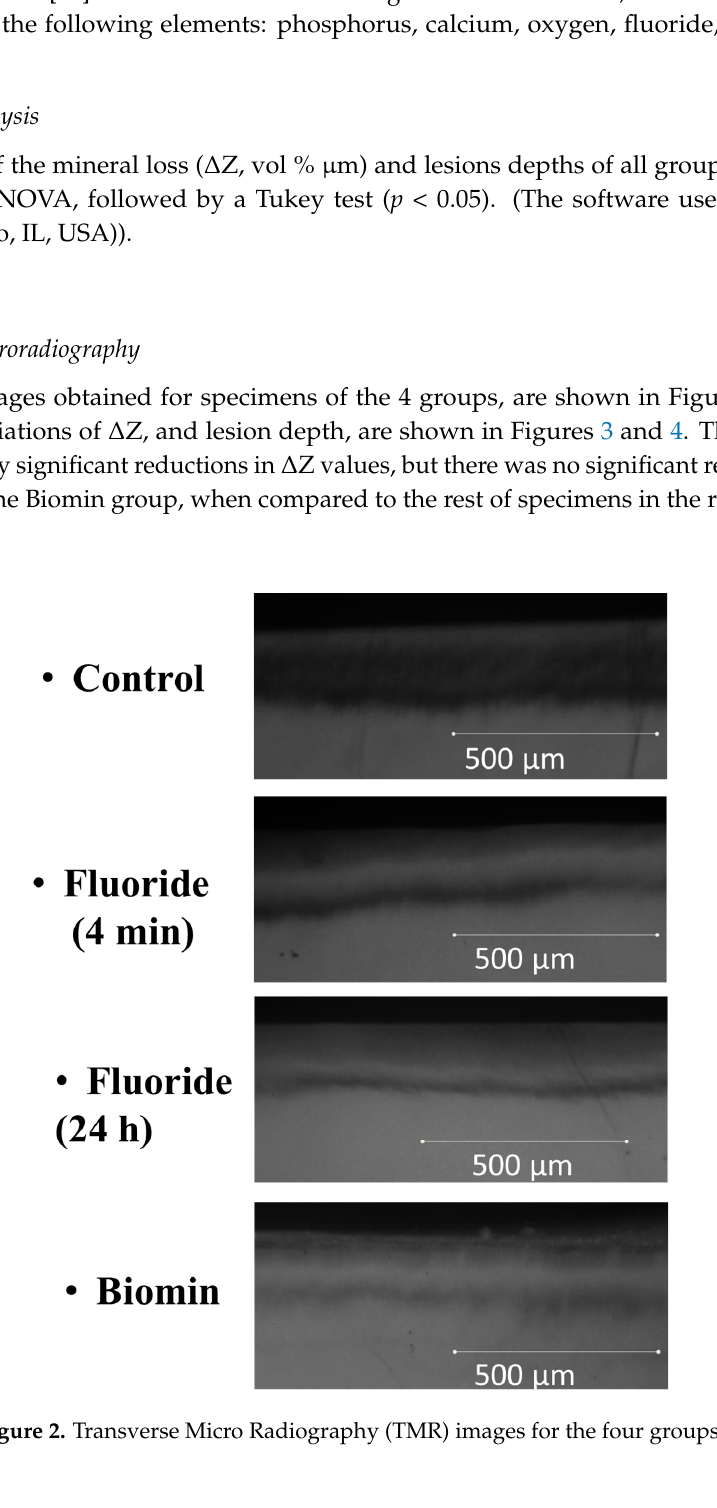
Figure 3. Mineral loss ( Δ Z) after treatment protocols presented by bar chart and Table. Bars with same letters were not statistically significant α = 0.05. Control